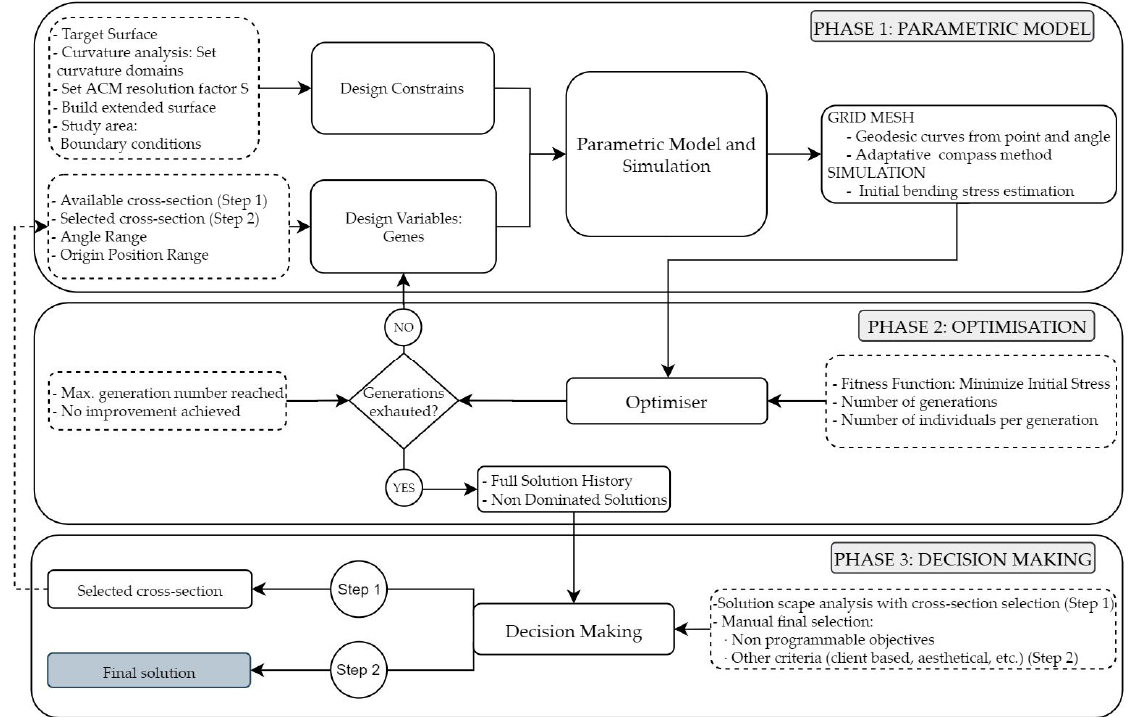
Figure 2. Workflow diagram of the proposed design process.